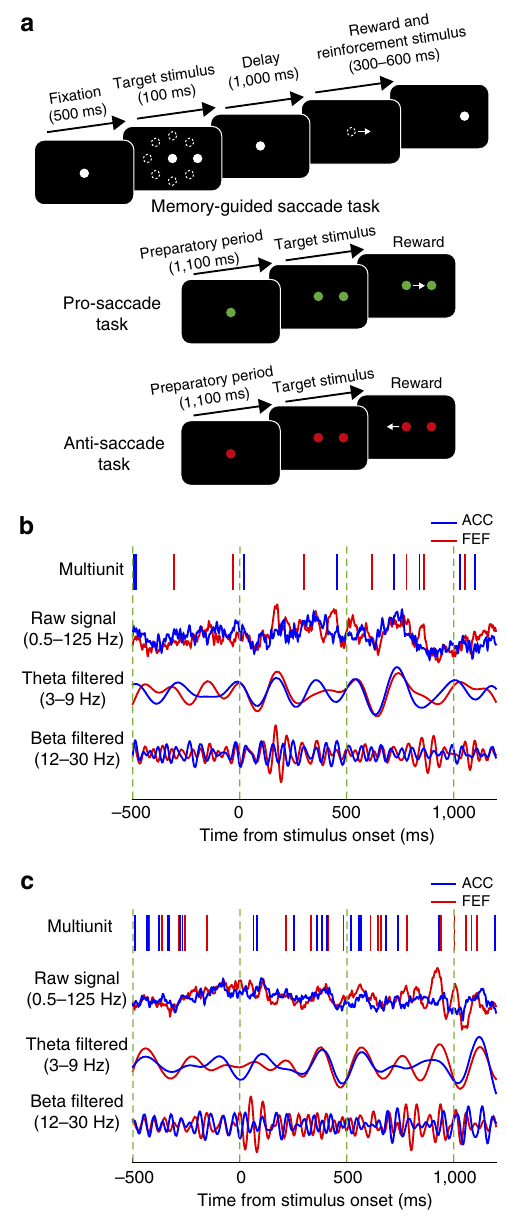
Figure 1 | Experimental paradigm and sample traces of simultaneously recorded activity in ACC and FEF. ( a ) Schematic of the memory-guided saccade task and pro-/anti-saccade task. ( b ) The traces show the multiunit activity, raw LFP signal (0.5–125Hz), theta band-pass-filtered signal (3–9Hz), and beta band-pass-filtered signal (12–30Hz) in a trial of memory-guided saccade task. ( c ) Same as in a in another memory-guided saccade task trial. The vertical green dashed lines indicate the 500ms time intervals aligned on stimulus